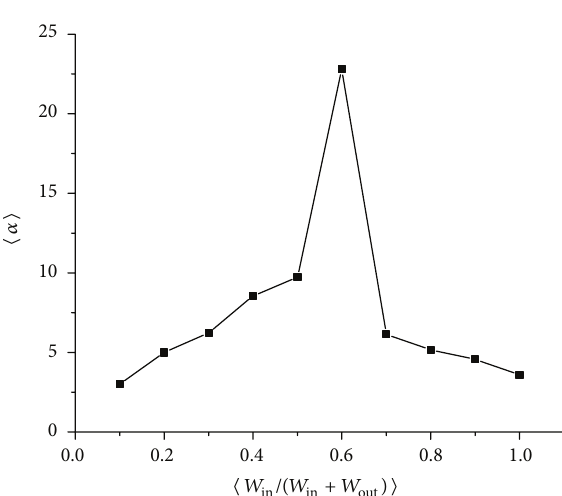
Figure 10: Plot of correlations between the average dynamic community age ⟨𝛼⟩ and the average community tightness parameter /(𝑊 + 𝑊 )⟩ in a dynamic ⟨𝑊 in in out